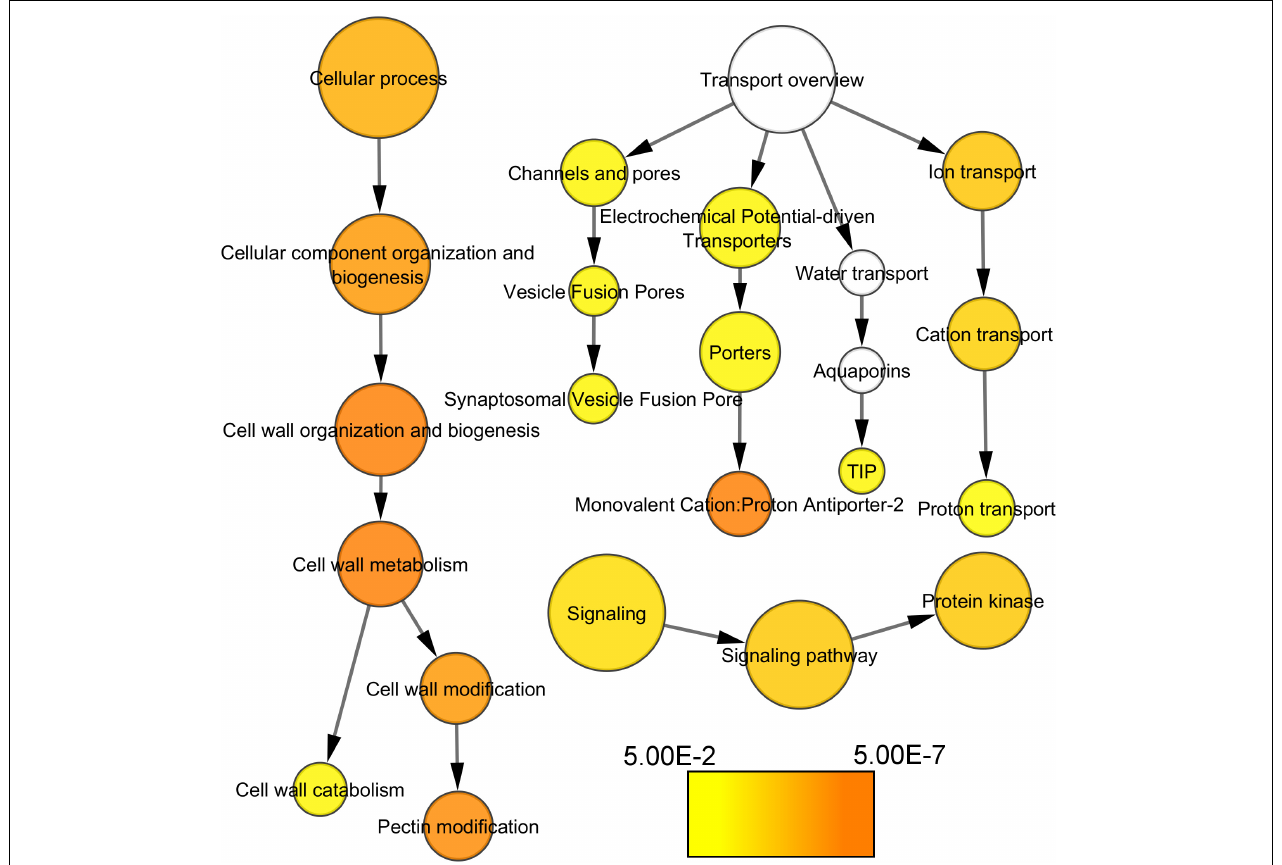
FIGURE 4 | Functional categories of the genes significantly over-represented at E-L 18–19 in compact clones vs. VP11 (adj. p -value < 0.05). Colors are function of significance. White, not